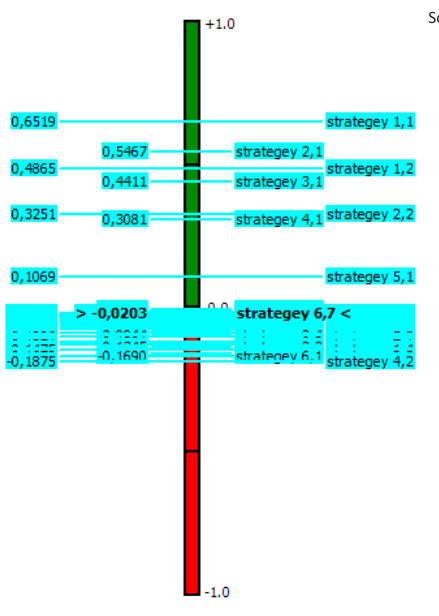
Figure 4. PROMETHEE II at Assumption